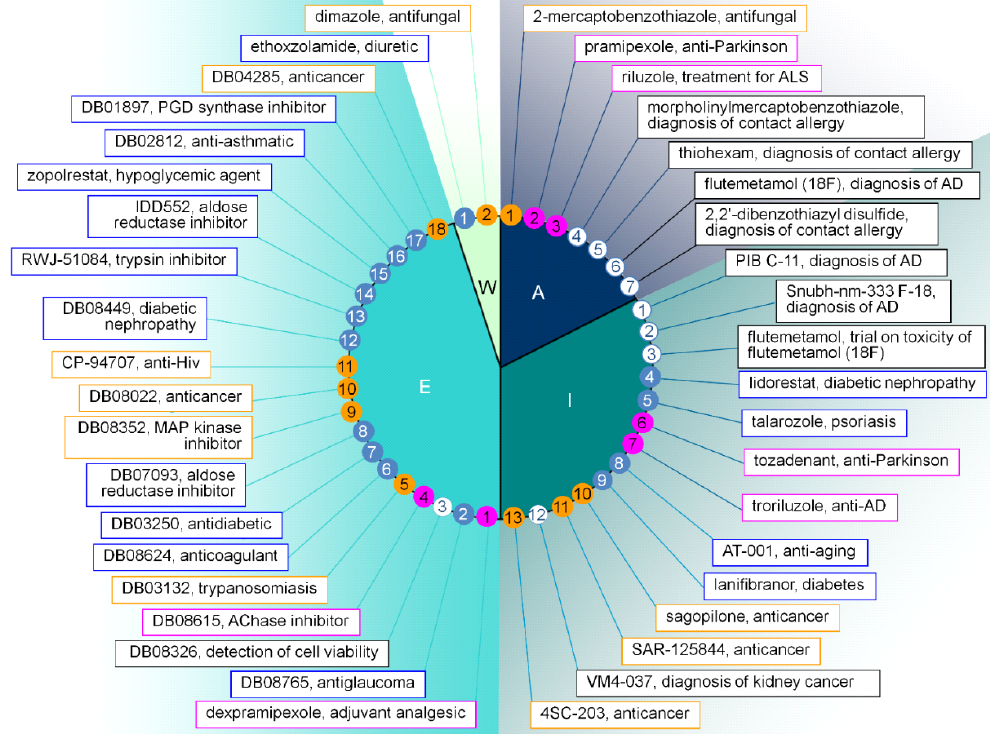
Figure 1. Common names and therapeutic applications of the 1,3-benzothiazole drugs included in DrugBank [3]; A: approved, I: investigational, E: experimental, W: withdrawn; each drug has been color-coded as follows: yellow = etiotropic agent, magenta = drugs acting on CNS, white = diagnostic, and blue = pharmacodynamic agent (see text for details).